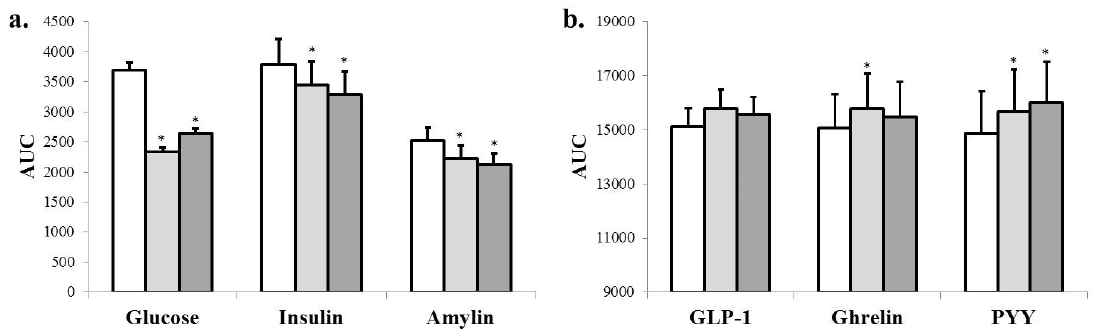
Figure 4. Integrated area under the curve (AUC) for peak areas of glycemic indices ( a ) and gut hormones ( b ) after a mixed meal with either SC treatment compared to placebo. The AUC units are as follows: glucose (mg × min/dL); insulin (µIU × min/mL); and amylin/GLP-1/ PYY (pg × min/mL). * p < 0.05, Differs compared to placebo for glucose (×5), insulin, amylin, ghrelin (×0.5) and PYY.